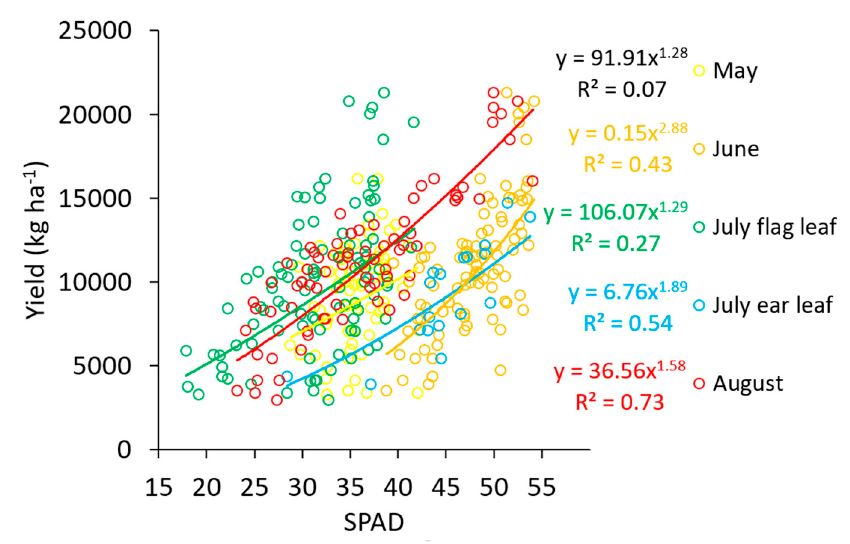
Figure 4. A comparison between the SPAD readings (dimensionless) at four different dates (May, June, July or August) and the final yield (as grain dry matter). Each circle is the average of 15 SPAD readings per plot and was obtained from the last fully expanded leaf in May (N = 96) and June (N = 120), from the flag (N = 120) or from the ear leaf (N = 24) in July, and from the ear leaf in August (N = 76).